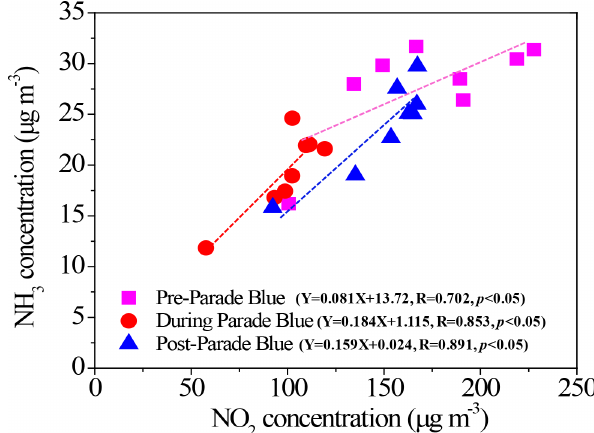
Figure 5. Correlations between NO 2 and NH 3 concentrations mea- sured on the fifth ring road in Beijing during the pre-Parade Blue, Parade Blue and post-Parade Blue